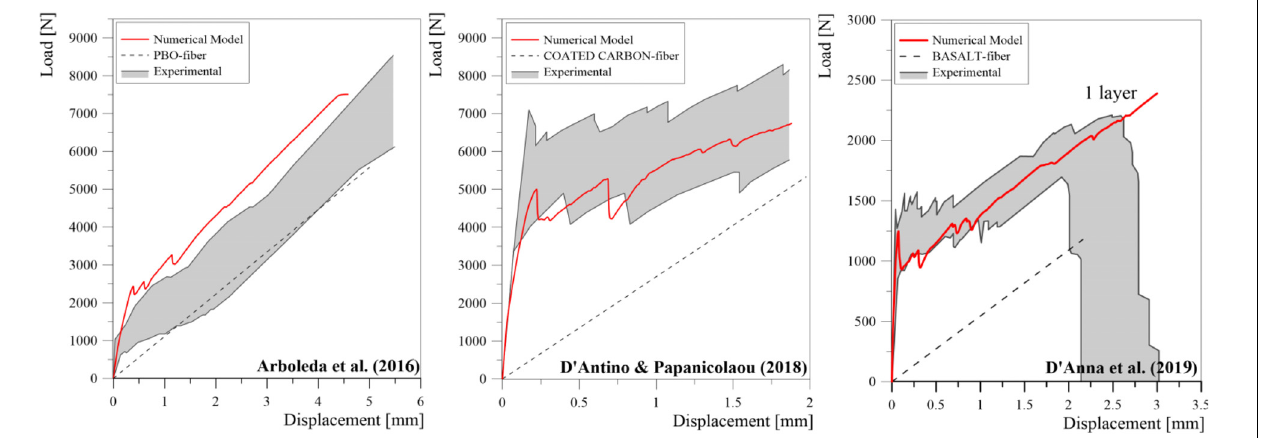
FIGURE 10 | Model validation.